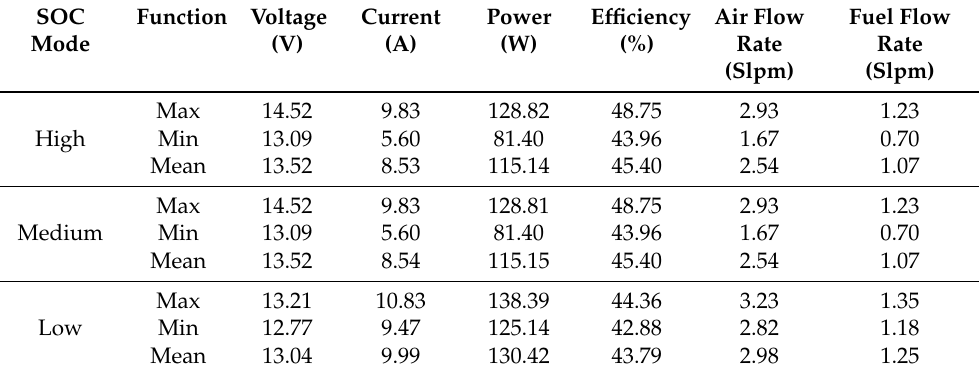
Table 7. FC response in high, medium and low SOC semi-active hybrid simulation.